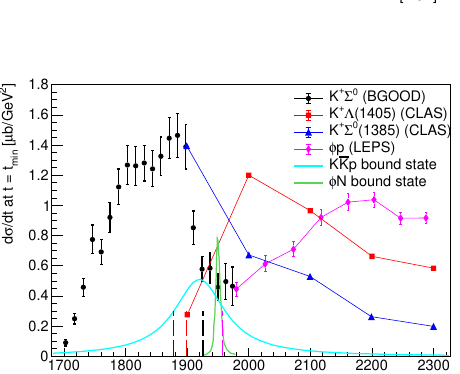
Figure 4. γ p → K + Σ 0 di ff erential cross section > 0 . 90 (black circles). The for cos θ K CM systematic uncertainties on the abscissa are in three components, where the grey bars are the total. Previous data (only including statistical errors) is indicated in the legend. The CLAS data are at the more backward angle of < 0 . 95. The Bonn-Gatchina 0 . 85 < cos θ K CM PWA solutions with and without the inclusion of the new data are the solid magenta and dashed cyan lines respectively. The pK + K − threshold is indicated by the dashed black line. Figure and references in Ref. [14].